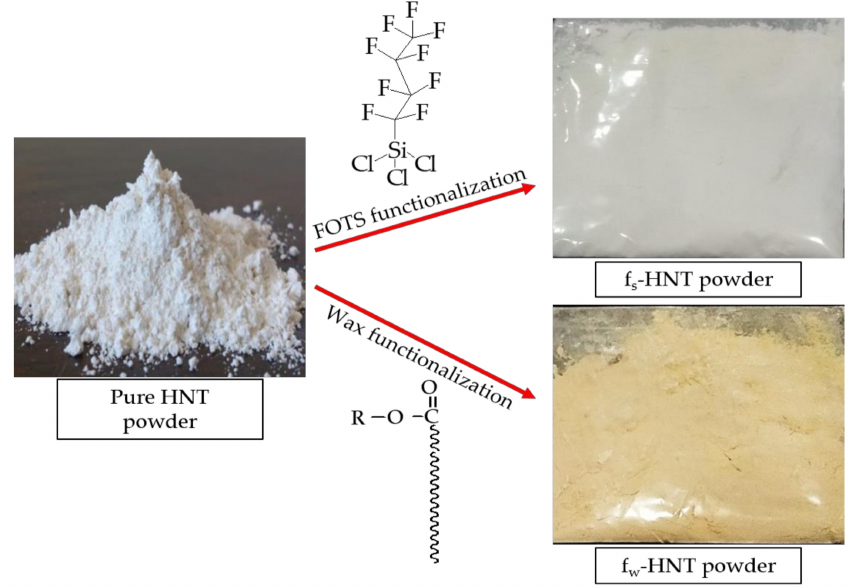
Figure 4. The change of powder color of pure HNT from white to yellowish after undergoing the functionalization process by carnauba wax (f w -HNT) and no color change was observed for 1H,1H,2H,2H-perfluorooctyl-trichlorosilane (FOTS)